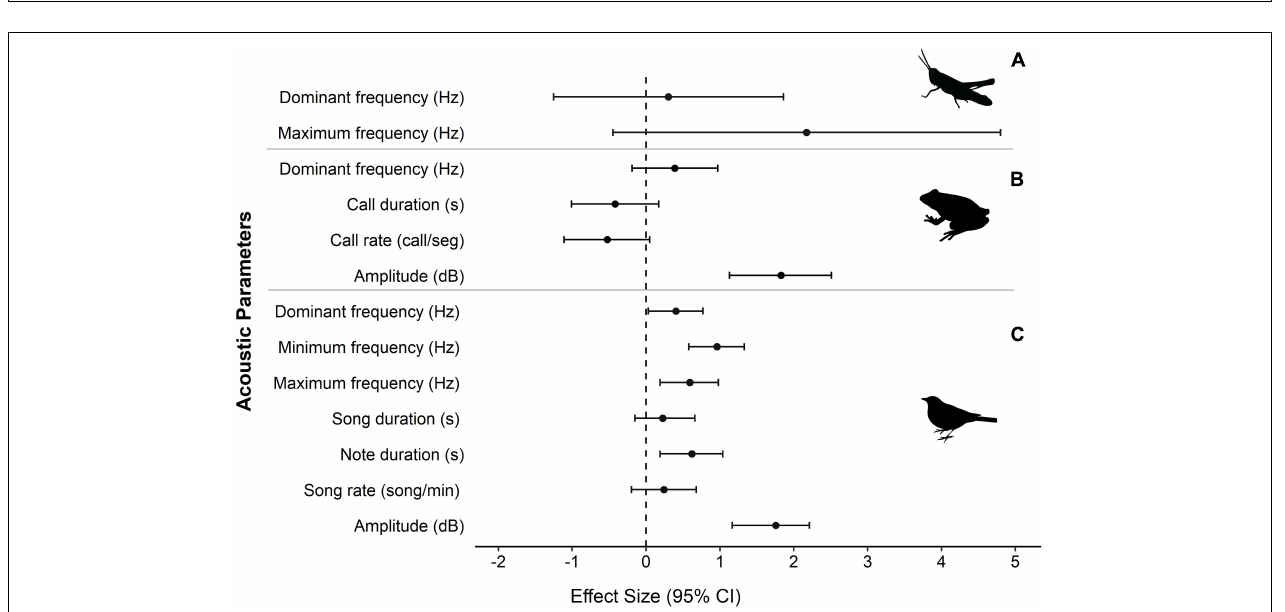
FIGURE 3 | Geographic distribution of studied sites included in the meta-analysis. Color-coded circles represent different taxon, solid circles represent studies that had one or two sampling sites, and each different shape (square and triangle) represent a study that had more than two sampling sites.